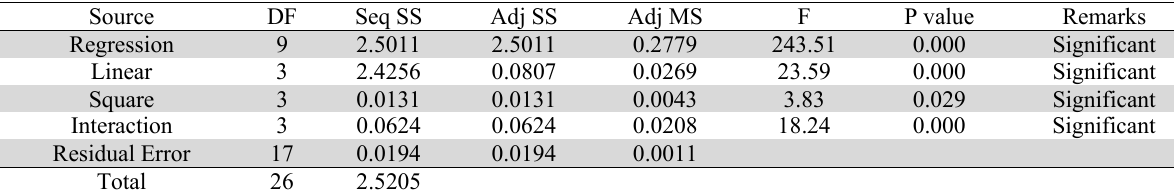
Results of ANOVA for Ra 2 nd order